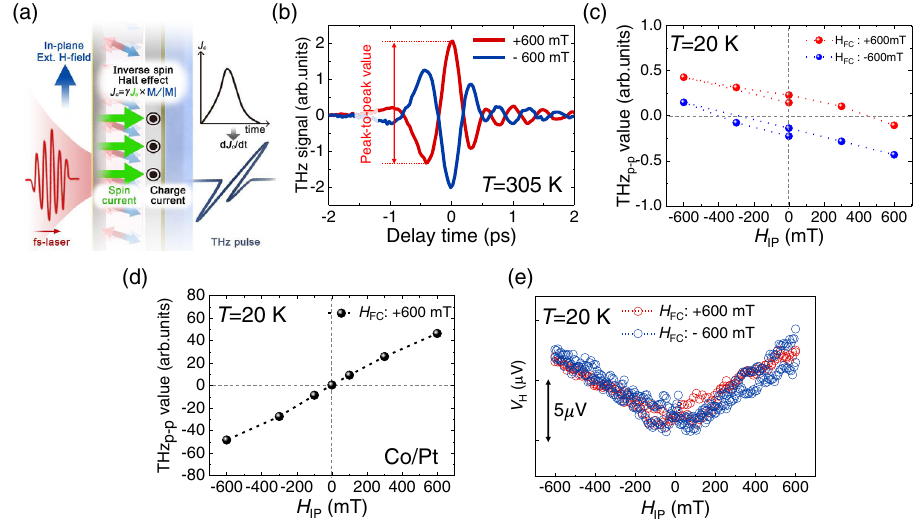
Fig. 4 | THz emission measurement results. a Schematic of principle of THz emission in magnetic/nonmagnetic bilayer sample. b Measured THz time traces according to external magnetic fi elds with 400-nm pump at 305K. c Peak-to-peak valuesofTHzwavesgeneratedfromTbCo/Ptaccordingto fi eld-coolingconditions